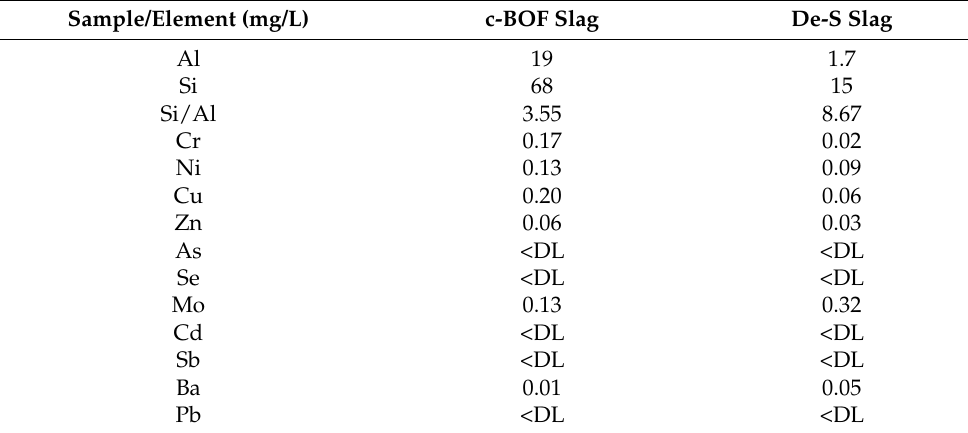
Table 4. ICP-OES determination of the soluble Si and Al atoms, heavy metals and amphoteric elements in the leachate after the NaOH 8M solution test at 80 ◦ C (the error associated with the measure is 30%), DL = detection limit.